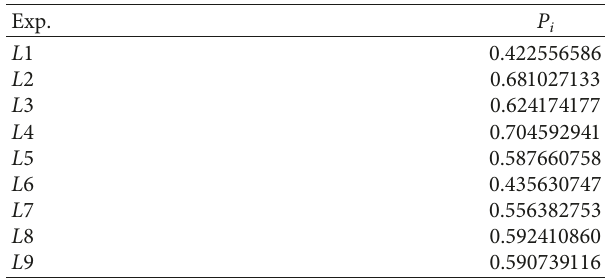
B − i ) and ideal ( i ).